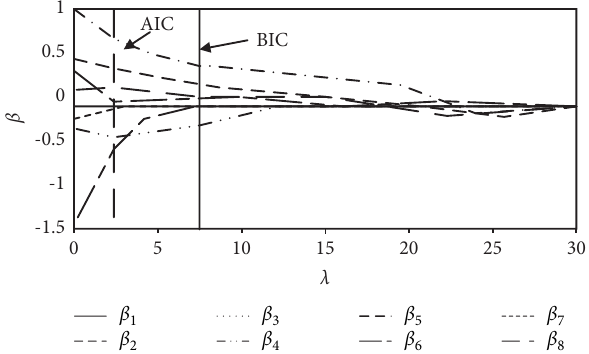
Figure 5: LASSO experimental results of PBC data